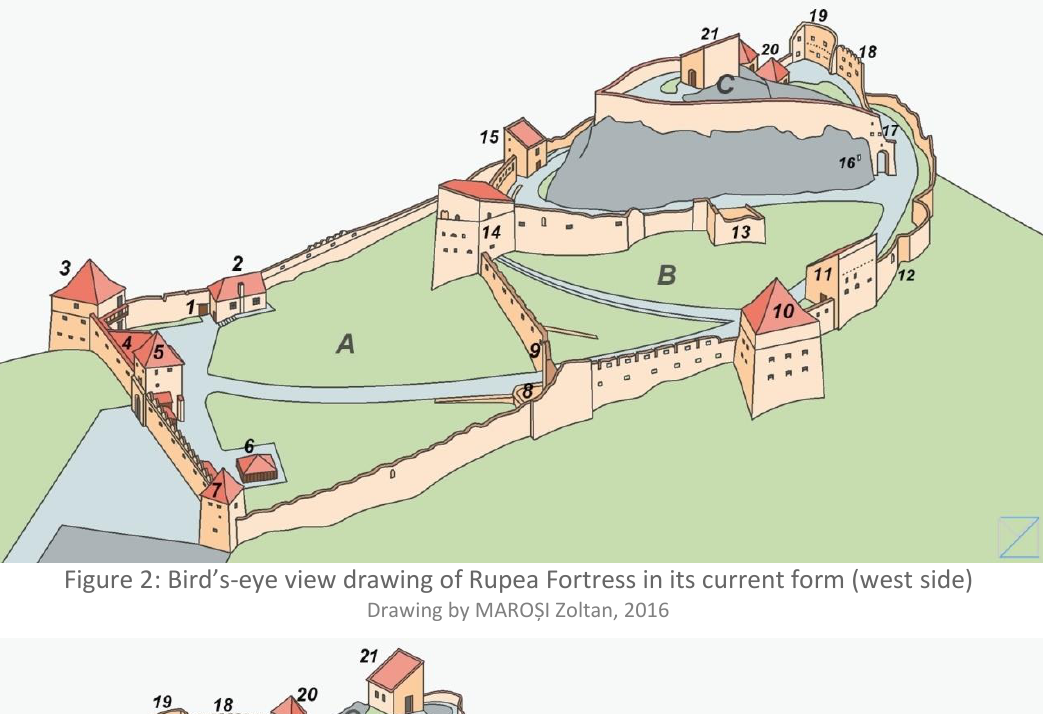
Figure 2: Bird’s-eye view drawing of Rupea Fortress in its current form (west side) Drawing by MAROȘI Zoltan, 2016